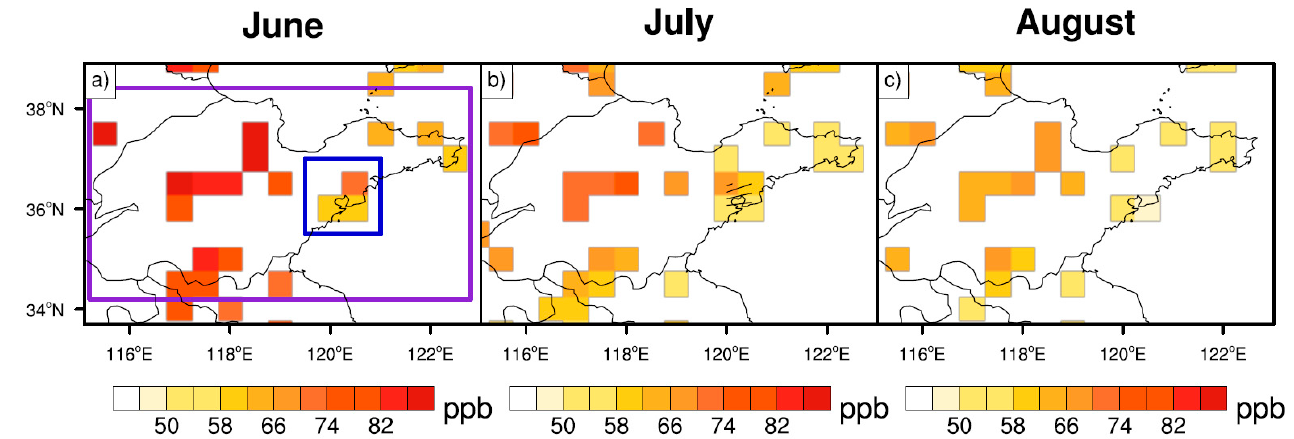
Figure 2. Monthly observations of MDA8 ozone concentrations (unit: ppb) at each grid in Shandong for ( a ) June, ( b ) July, and ( c ) August from 2014 to 2019. The blue and purple boxes in panel ( a ) denote Qingdao and Shandong Province, respectively.